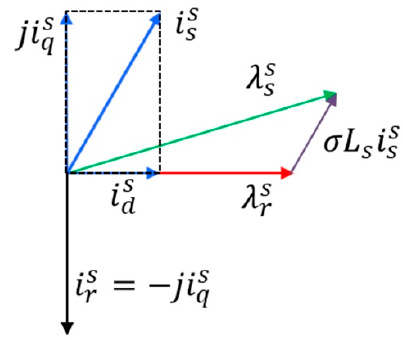
Figure 5. Phasor diagram of the Inverse- Γ equivalent model.